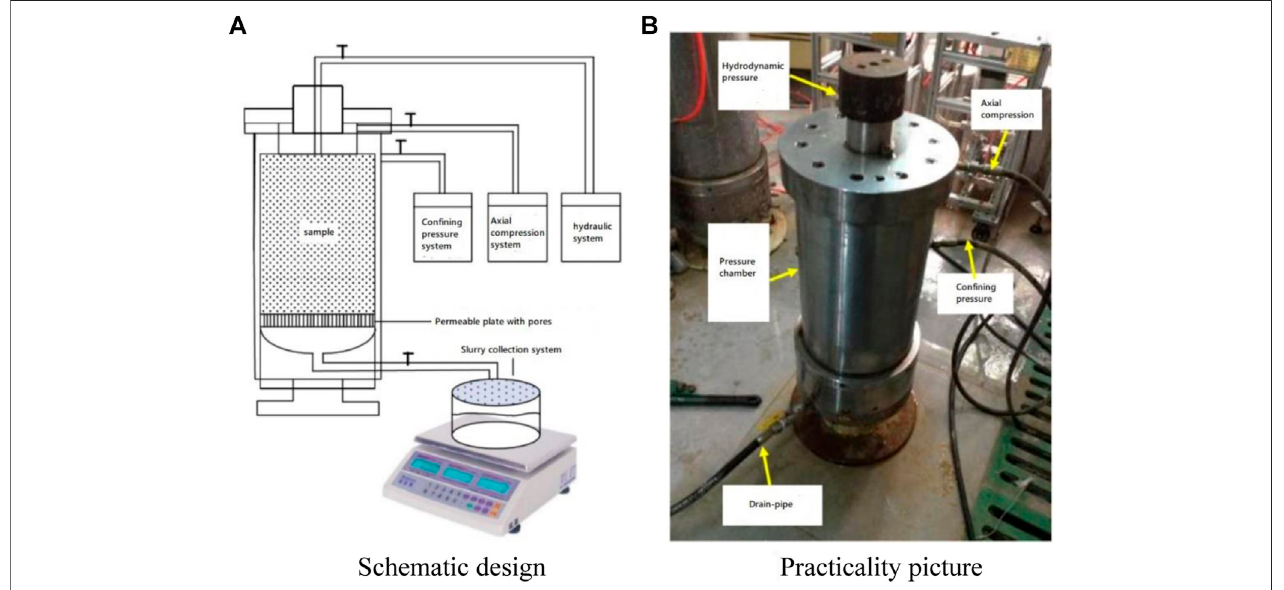
FIGURE 1 | Large triaxial testing system: (A) schematic design and (B) practicality picture.